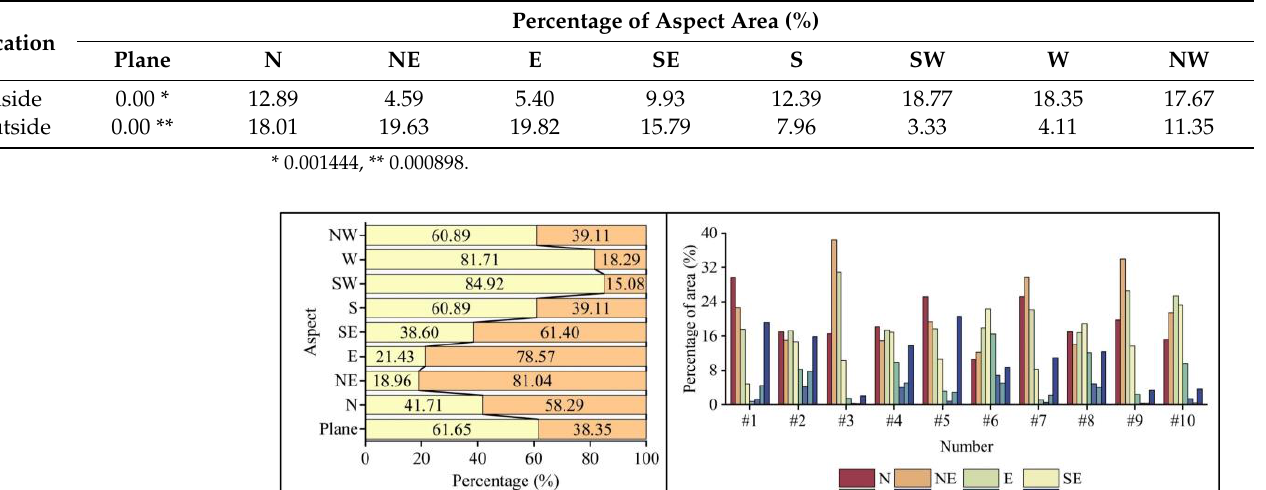
Table 8. Statistical results of the proportions of the inside and outside aspect areas of the pit rim structure.